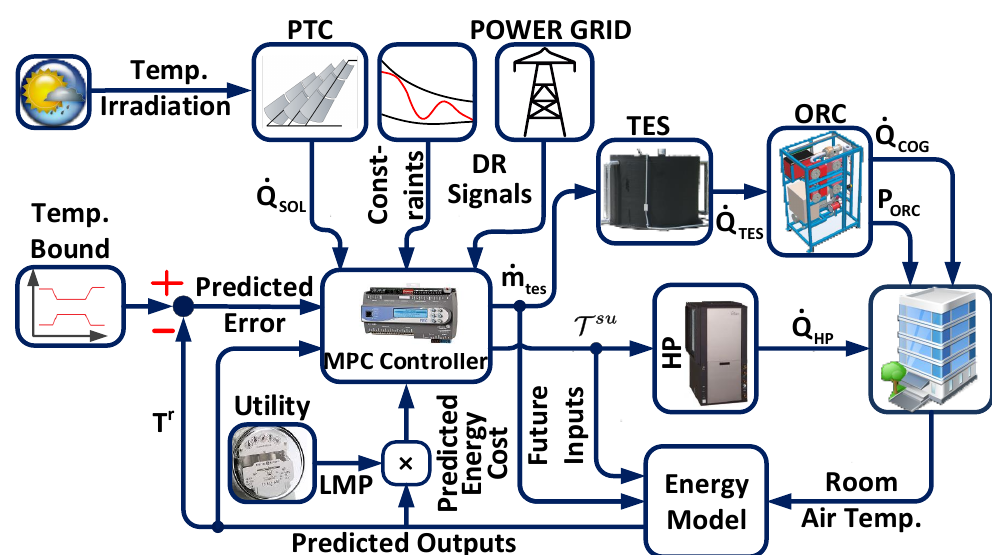
Figure 18. Structure of the MPC based on building to grid demand response participation. (Adapted from [20] with permission of Elsevier)